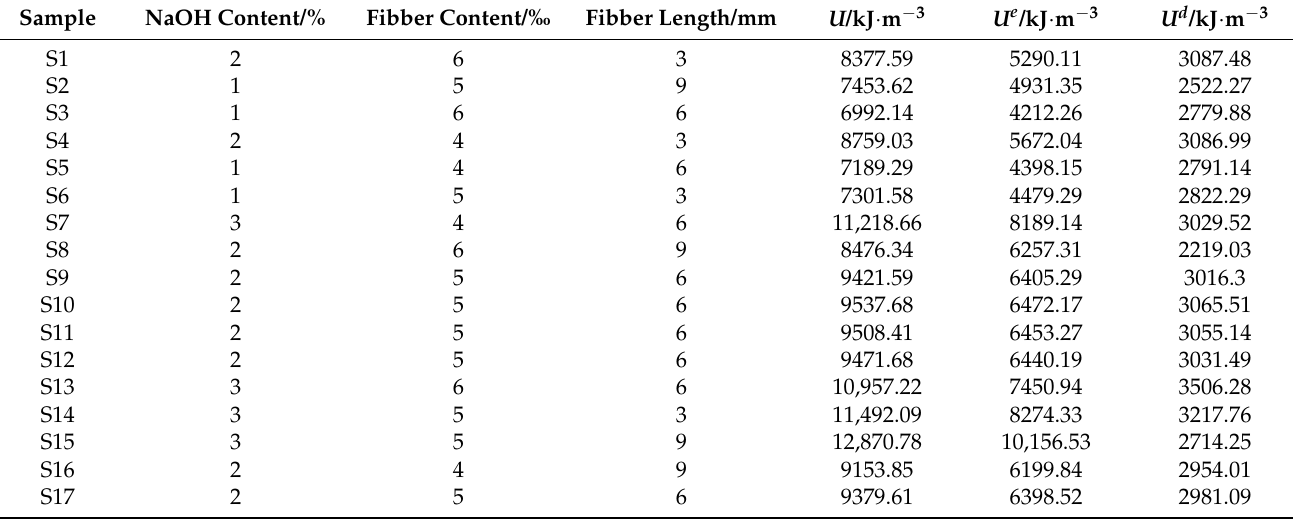
Table 12. Energy parameters of samples under different